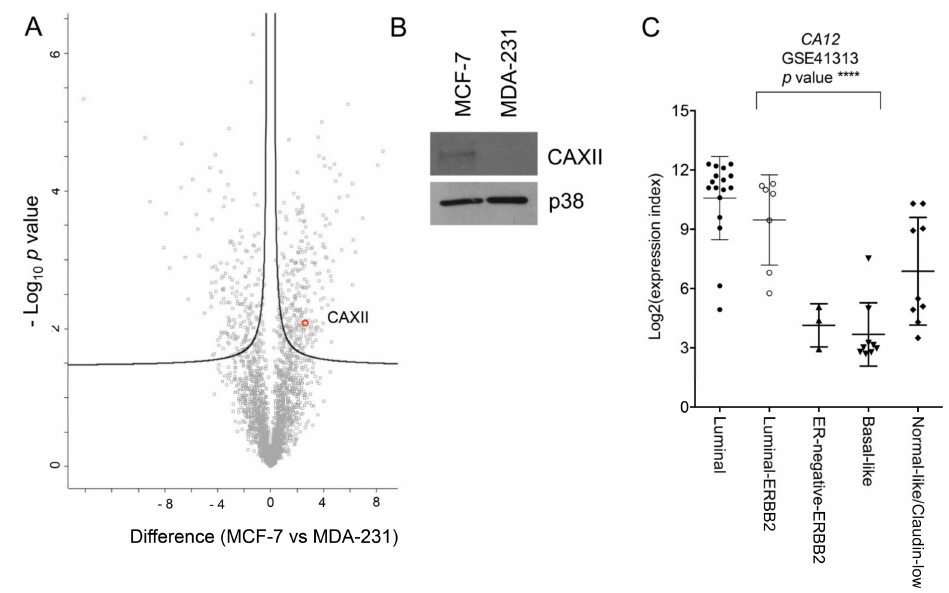
Figure 1. CA12 is di ff erentially expressed in breast cancer cell lines. ( A ) Proteins obtained by MS / MS analysis of MCF-7 and MDA-231 cells are ranked in a volcano plot according to their statistical p -value ( y -axis) and their di ff erence (log2 fold change). Carbonic anhydrase 12 (CAXII) is highlighted. The curve is derived at false discovery rate (FDR) = 0.05 and s0 = 0.1. ( B ) Western blot analysis of CAXII expression in MCF-7 and MDA-231 cells. P38 was used as a loading control. ( C ) Analysis of mRNA